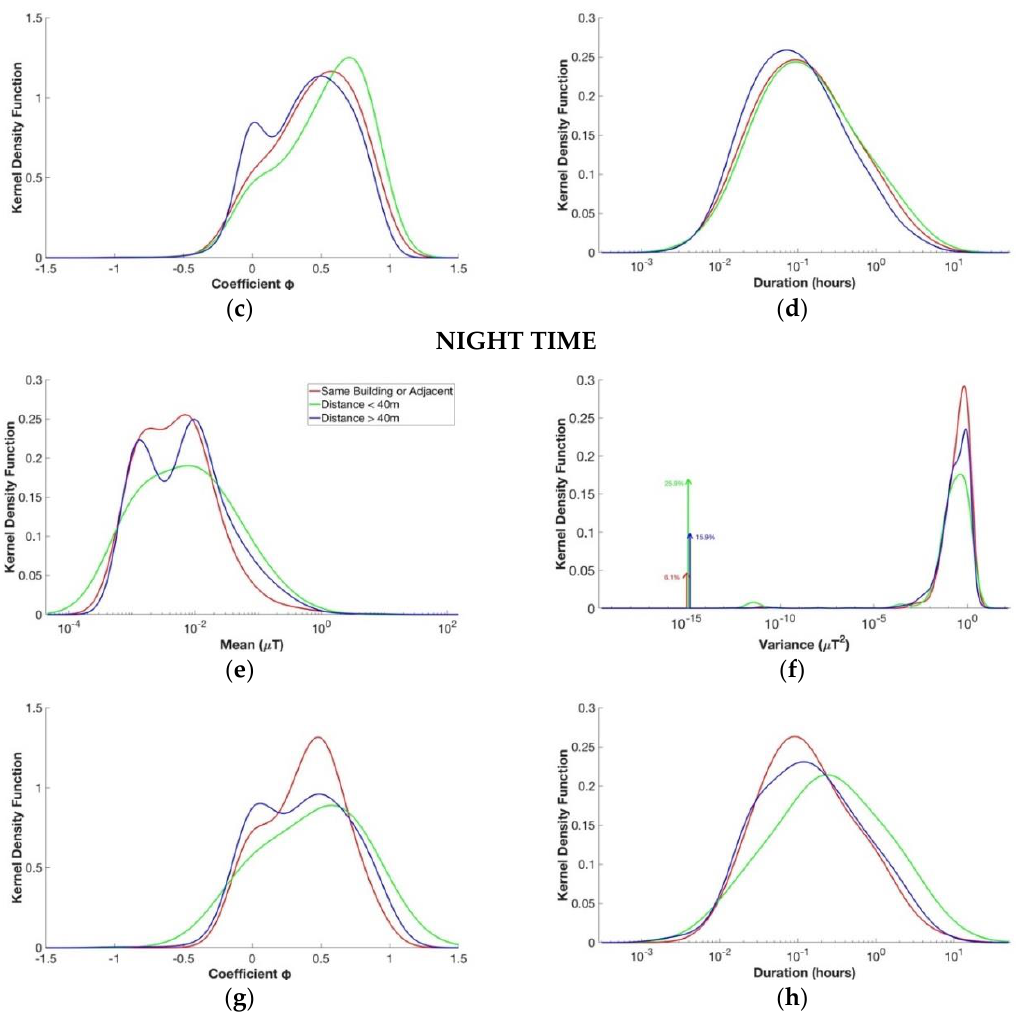
Figure 8. Estimated kernel density function for the four variables of the segments of the day in the upper part and for the segments of the night in the lower part. From above to down, left to right: ( a , e ) mean µ , ( b , f ) variance σ 2 , ( c , g ) coefficient ϕ , and ( d , h ) duration T. The groups considered are measurements where the children’s domicile was at least 40 m away from the substation (in blue), measurements where the substation was less than 40 m away from the children’s domicile (in green), and measurements where the substation is in the same building of the children’s domicile or adjacent to the children’s domicile (in red).